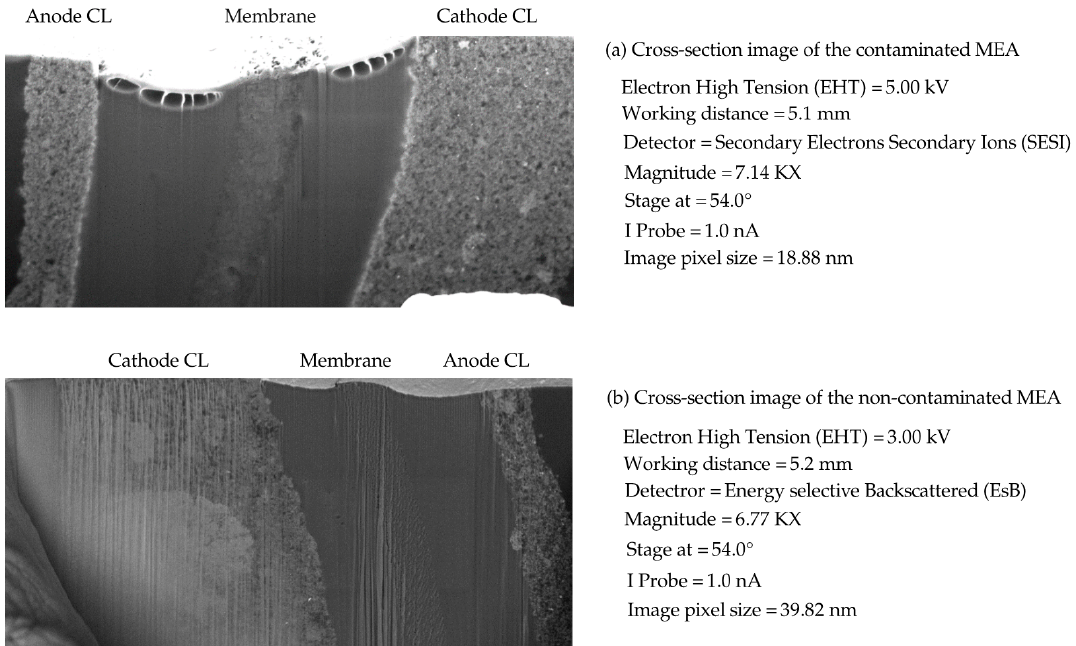
Figure 3. FIB-SEM cross-section images of the contaminated and non-contaminated MEAs: ( a ) cross- section image of the contaminated MEA, ( b ) cross-section image of the non-contaminated MEA.